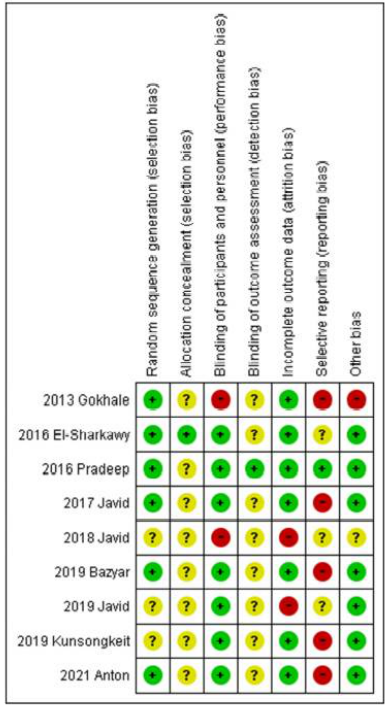
Figure 1. Risk of bias summary: Authors’ judgments about each risk-of-bias item for each included study.